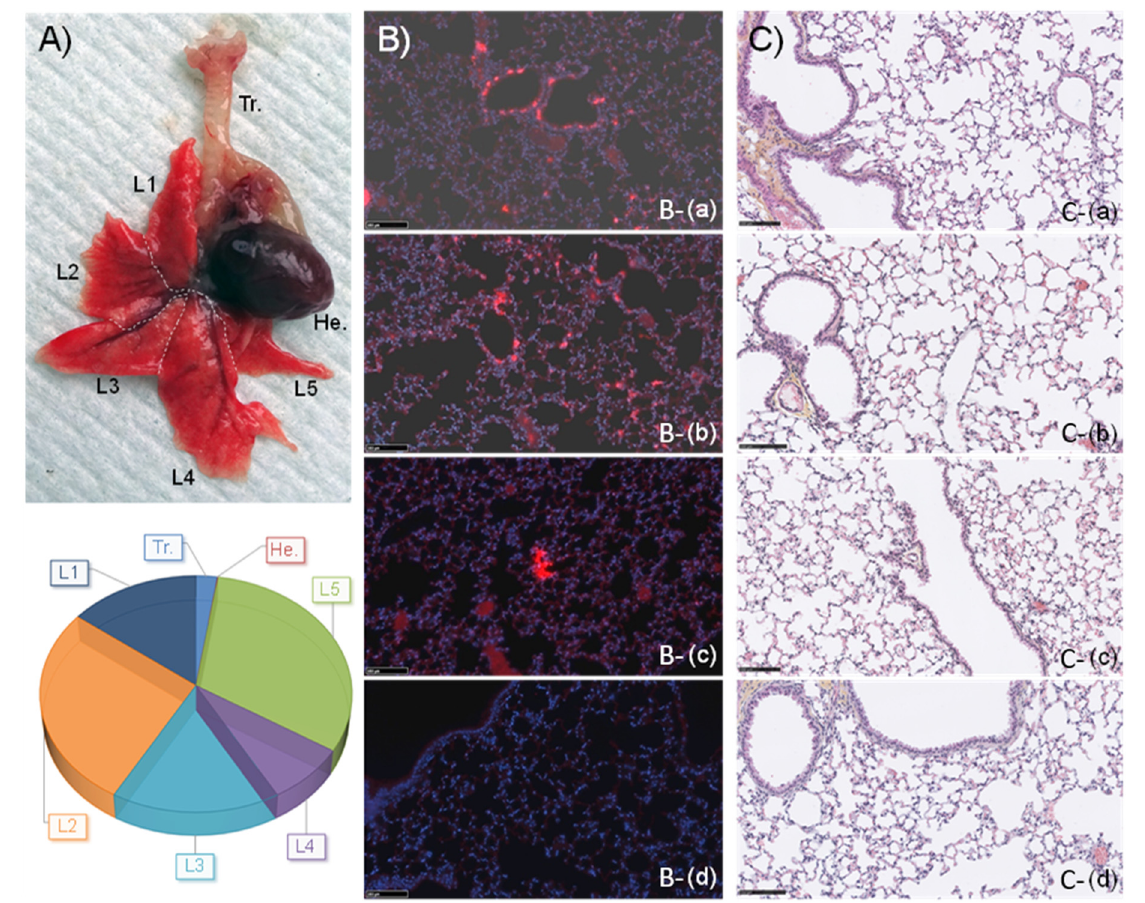
Figure 6. Luciferase expression in lungs 7 days after treatment of mice with an aerosol of F20 + L ([(CholP/DOPE 1/2 DP5K) + pGM144] CR2 PR2). Panel ( A ) illustrates the distribution of luminescence in lung lobes (L1–L5), heart (He.), and trachea (Tr.). Dashed white lines are used to help individualize the different lobes. The heart was used as a negative control for transfection. Panel ( B ) corresponds to immunohistochemistry analyses for luciferase detection in treated ( a – c ) compared to untreated ( d ) lungs. Luciferase-expressing cells and nuclei are stained with Rhodamine (red) and DAPI (blue), respectively. Panel ( C ) corresponds to hematoxylin and eosin (H&E) stain of lung sections from the same mice. The scale bar in every image is 100 µm. See Figure S5 for more images.